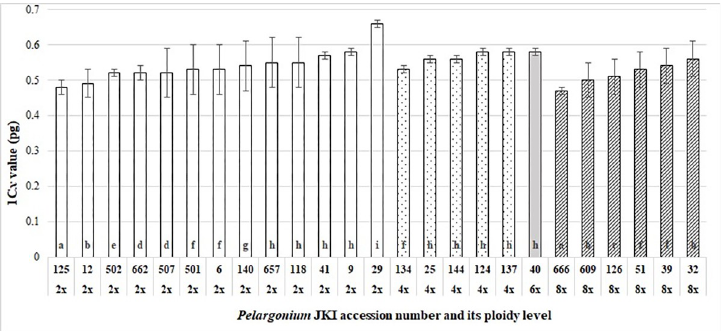
Fig 3. Mean 1C x value of 25 accessions of section Pelargonium . Different letters show significant differences, Tukey’s b test, α = 5%, n = 3–7.